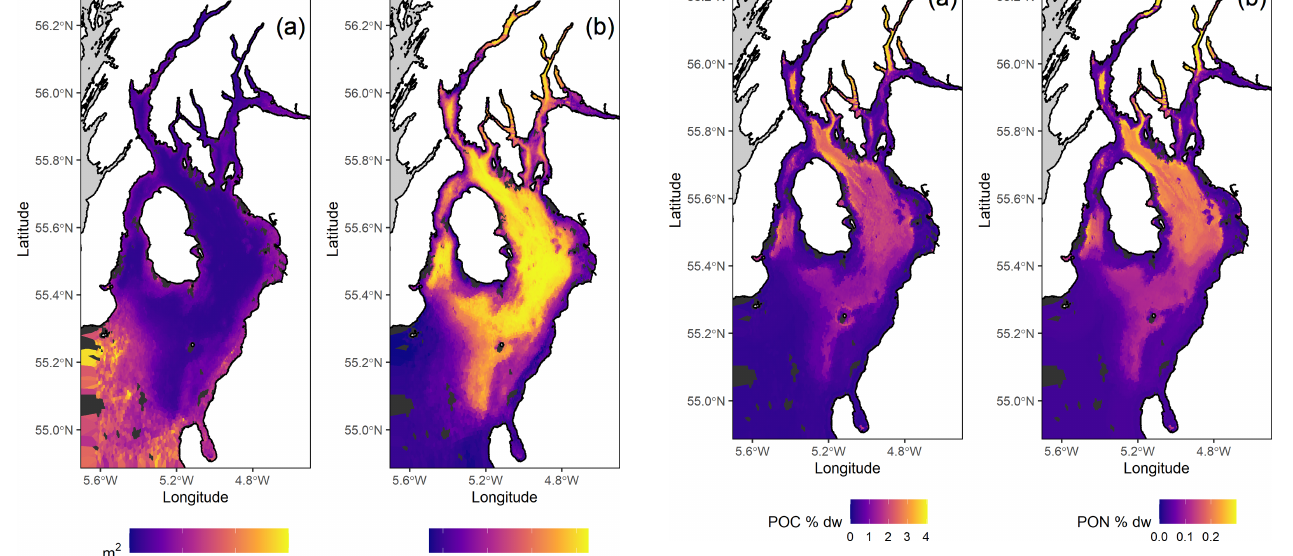
Figure 15. Maps of predicted percentage of dry weight sediment (a) organic carbon and (b) organic nitrogen content within the top 10cm of seabed in the Firth of